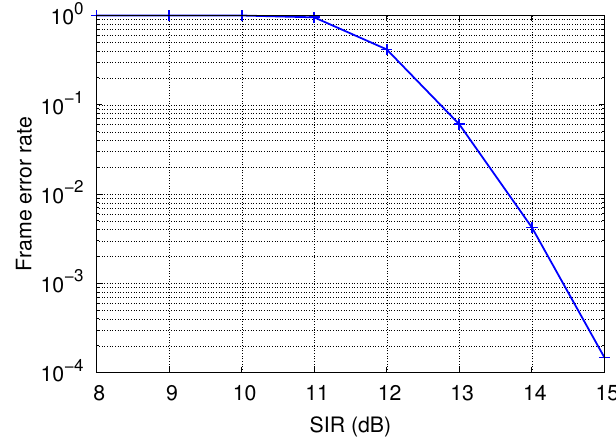
Figure 4. Frame error rate depending on signal-to-interference